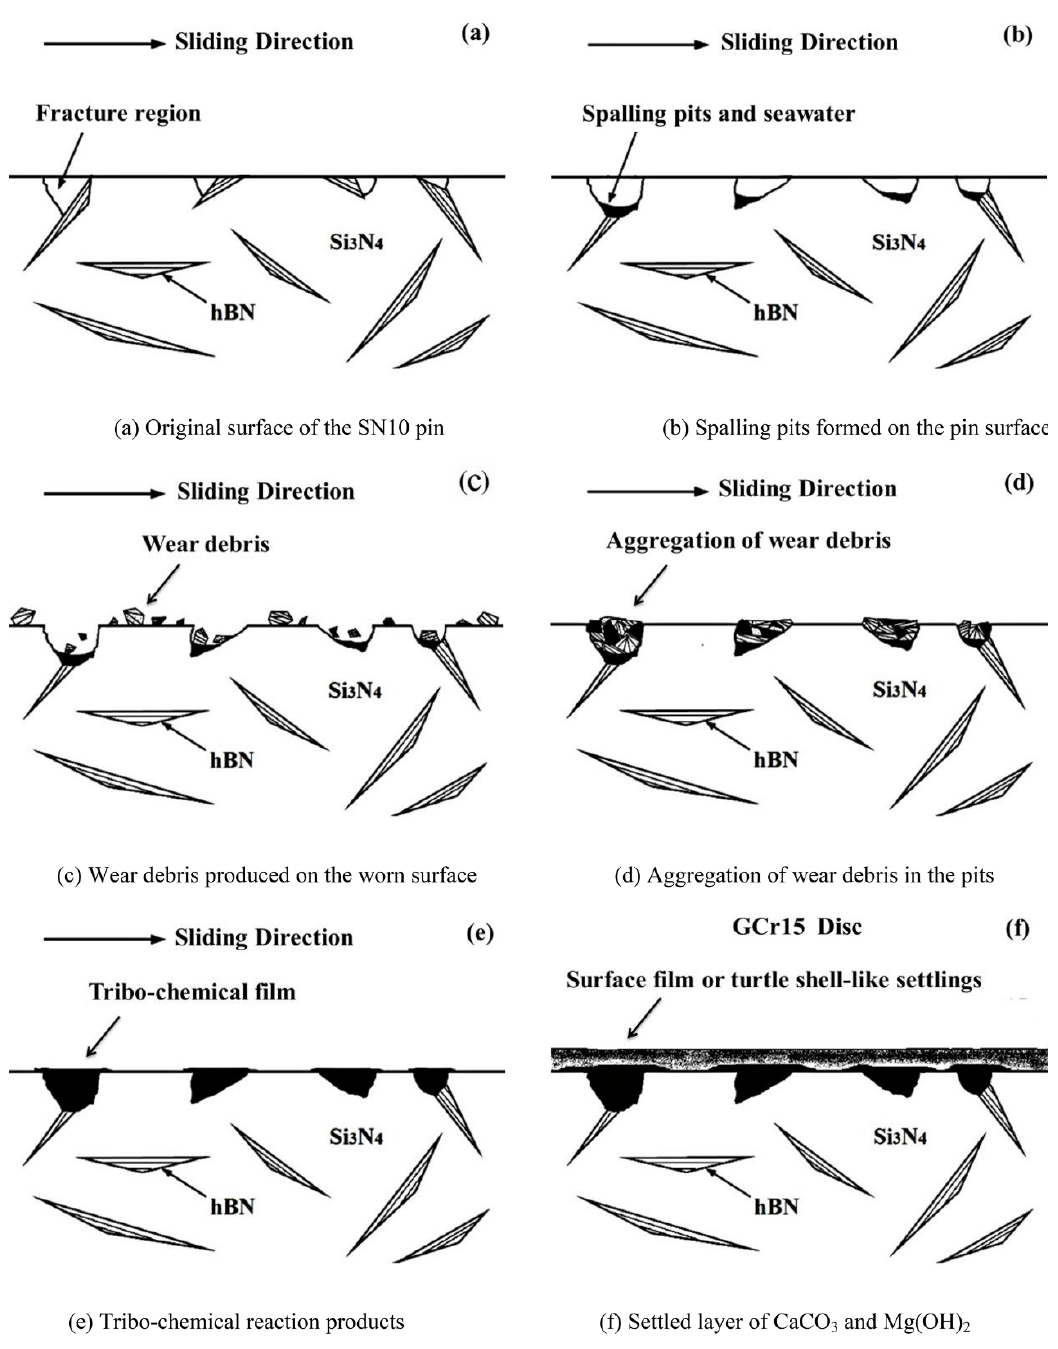
Figure 12. Schematic diagrams depicting wear models of the SN10/GCr15 tribopair in a seawater environment. Original surface of the SN10 pin ( a ), Spalling pits formed on the pin surface ( b ), Wear debris produced on the worn surface ( c ), Aggregation of wear debris in the pits ( d ), Tribo-chemical reaction products ( e ), Settled layer of CaCO 3 and Mg(OH) 2 ( f ). Table 5. Tribo-chemical products and wear mechanisms of the SN10/GCr15 tribopair under different lubrication conditions.